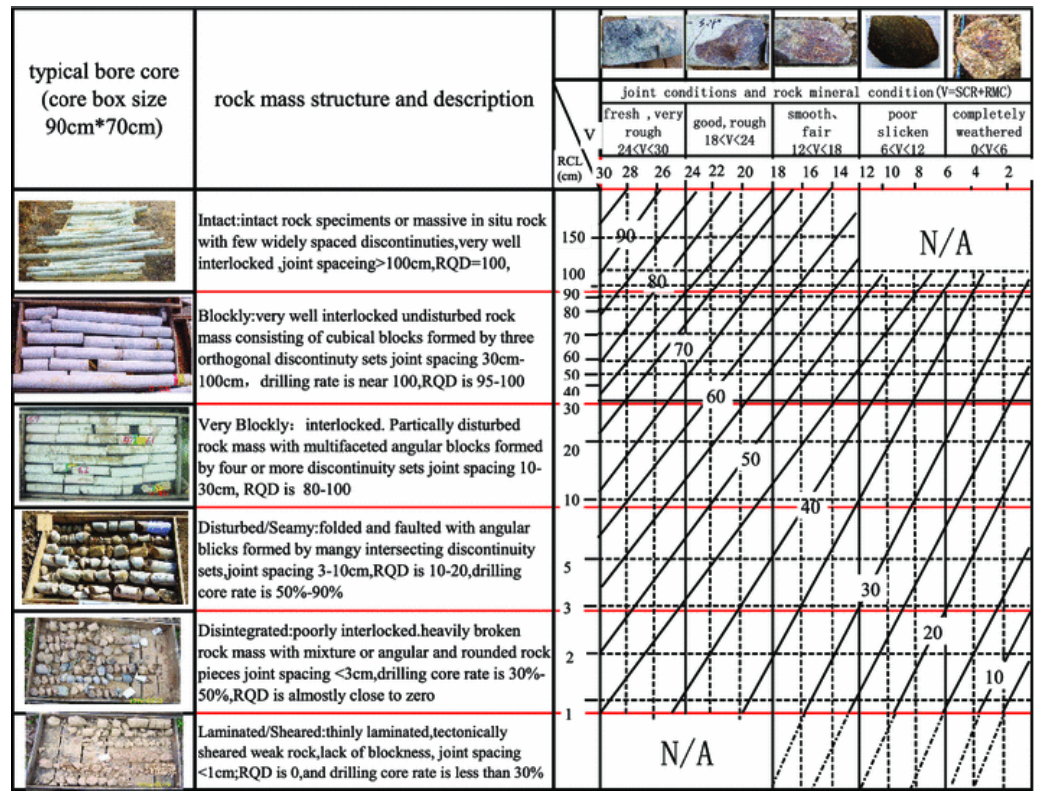
Figure A11. Quantified GSI chart [53].